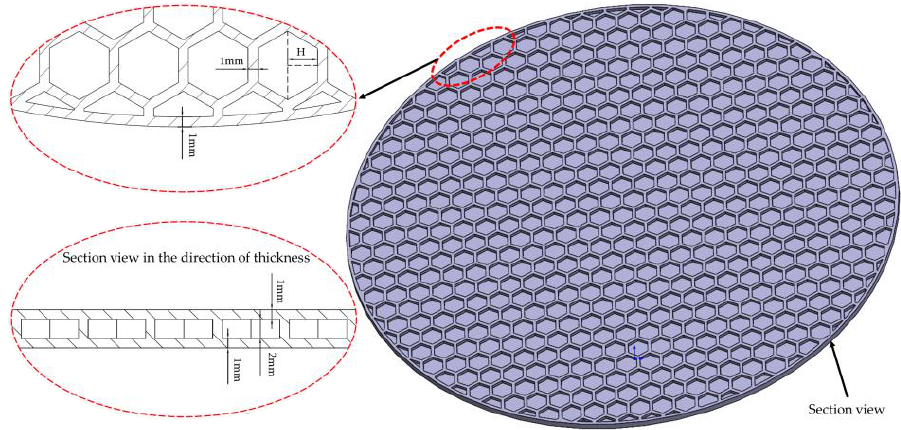
Figure 11. Structural parameters of the honeycomb panel.